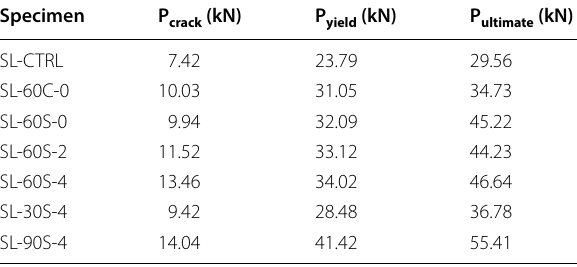
Table 7 Summary of experimental test